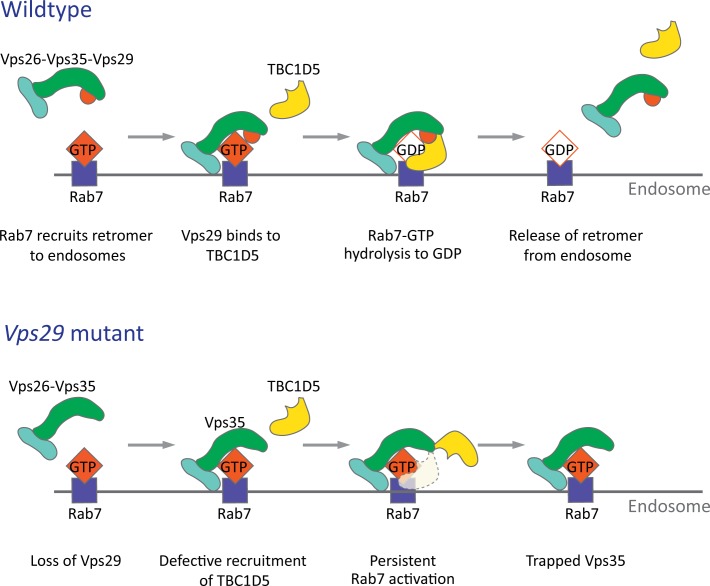
Model for Vps29-dependent retromer recruitment and release.In neurons, the retromer core Vp26-Vps35-Vps29 is recruited by Rab7 to the endosomal membrane. Vps29 engages TBC1D5, which promotes inactivation of Rab7 and release of Vps35. In the absence of Vps29, the residual retromer complex is trapped at the endosomal membrane.